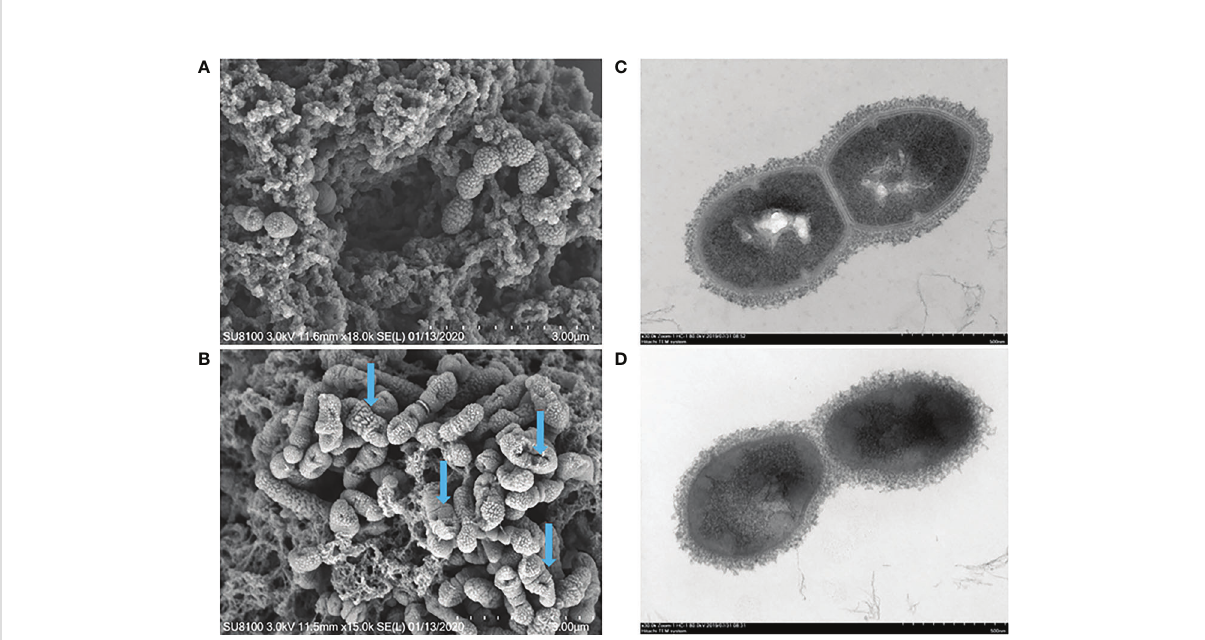
FIGURE 2 SEM and TEM analysis of SC19. (A) Untreated bacteria control analysis via SEM, the bar at the bottom right means 3 m m. (B) Bacteria treated with EGCG (512 m g/ml) analysis via SEM, the bar at the bottom right means 3 m m. (C) Untreated bacteria control analysis via TEM, the bar at the bottom right means 500 nm. (D) Bacteria treated with EGCG (512 m g/ml) analysis via TEM, the bar at the bottom right means 500 nm. The blue arrow indicated cellular damage caused by